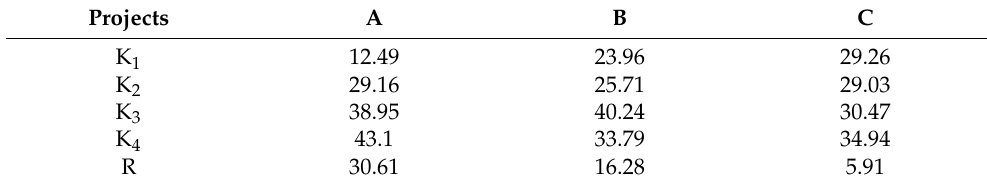
Table 4. Results of the range analysis.